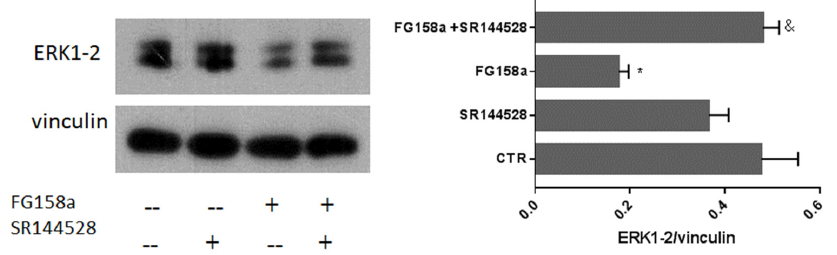
Figure 6. FG158a inhibition of ERK1/2 is mediated by CB2R. Western blot and densitometric